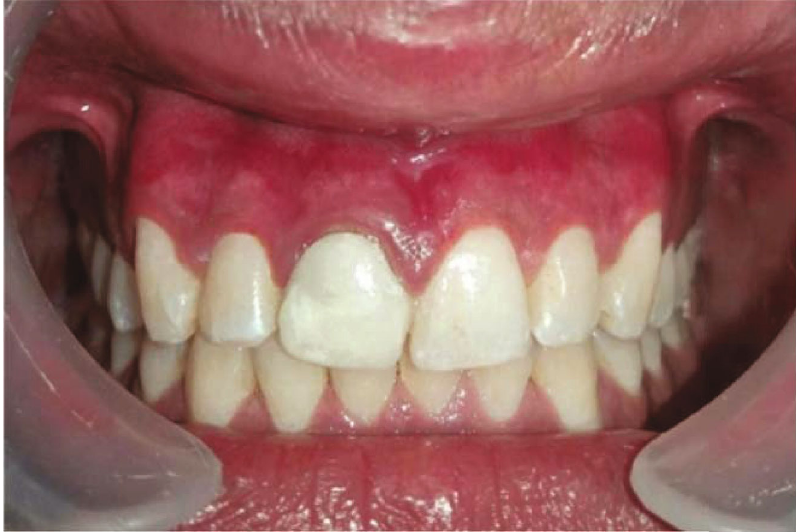
Figure 4: Clinical image of the upper anterior gingiva 4 months after, with no